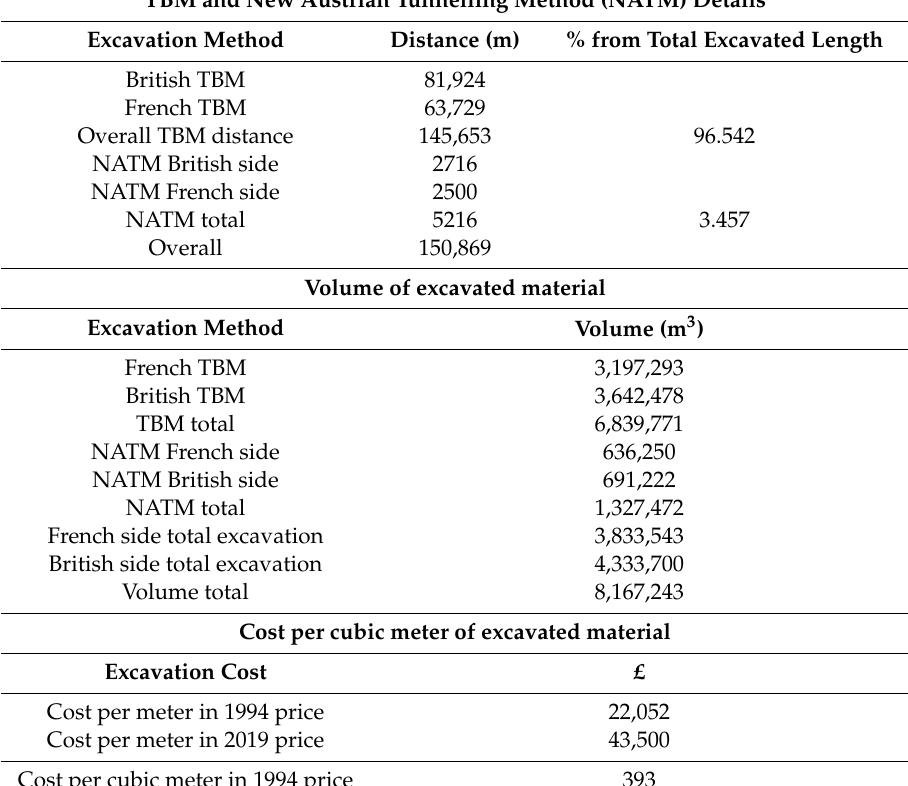
Table 6. Construction Methods and Cost Figures for the Channel tunnel (initial data taken from: [45], apart from